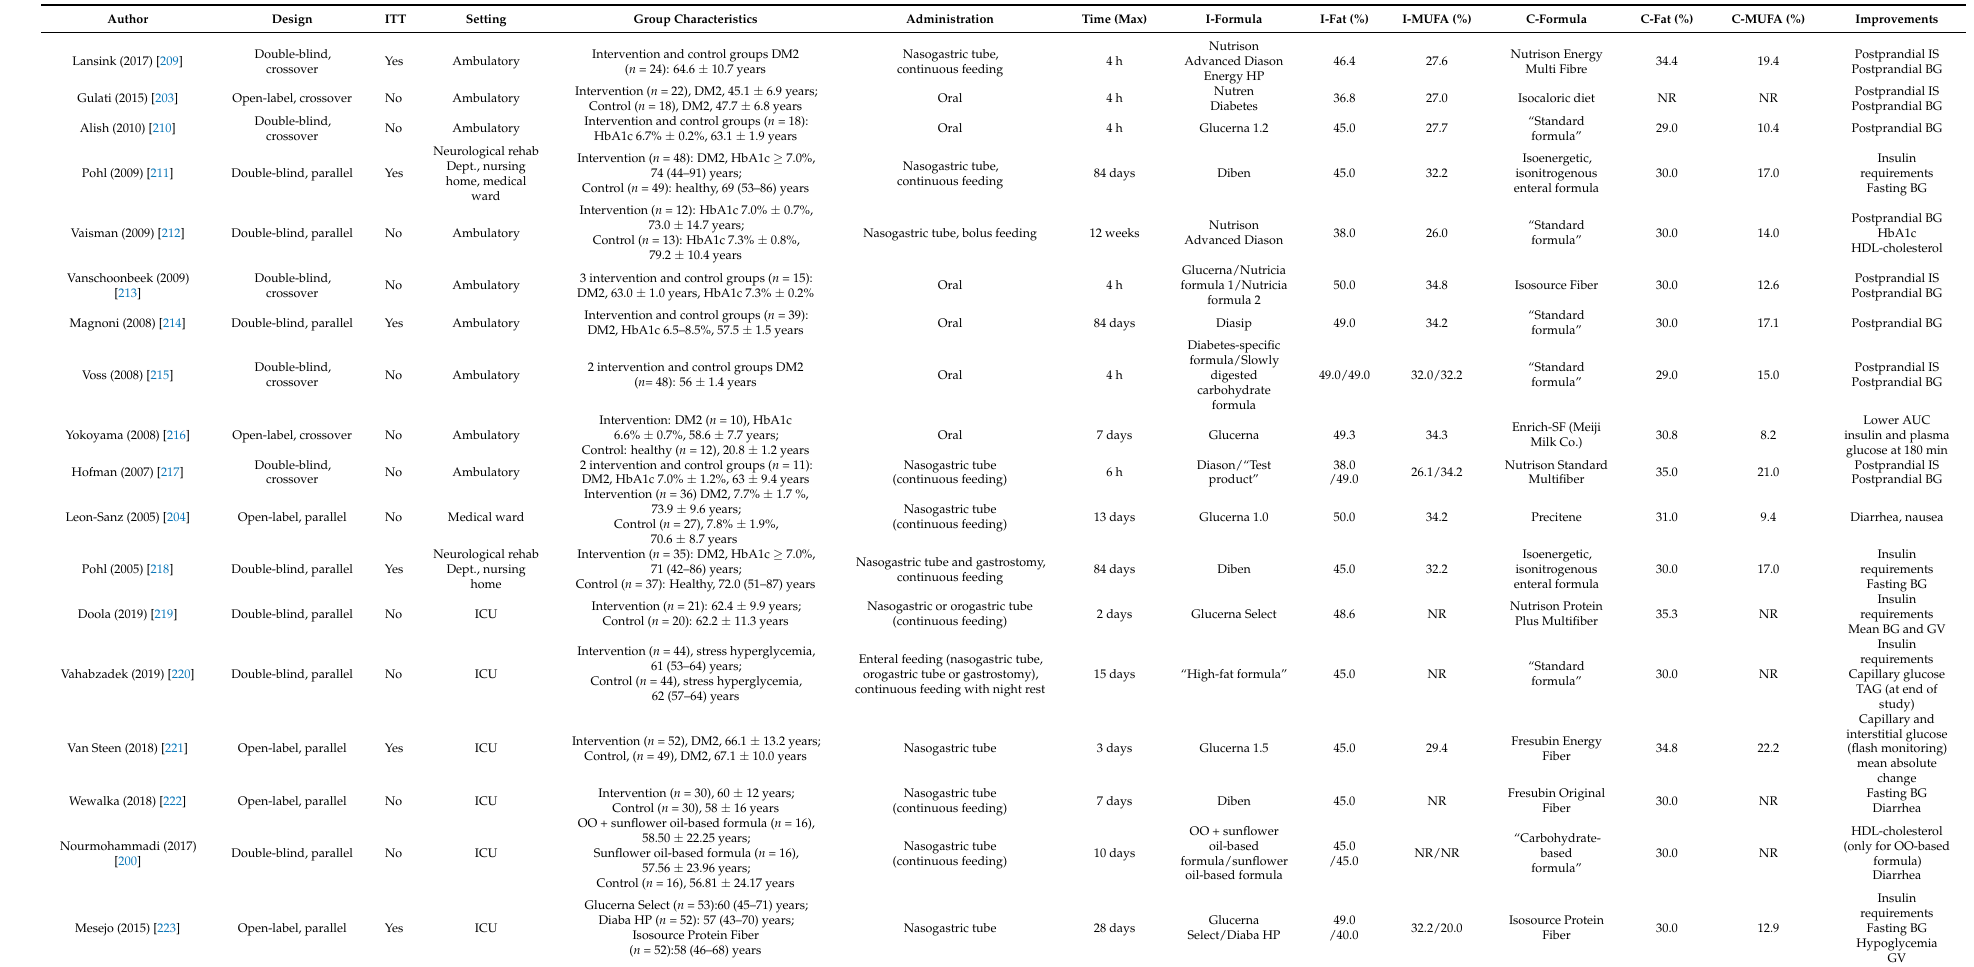
Table 1. Characteristics of the latest clinical trials that used MUFA-based FEEDs. Modified from